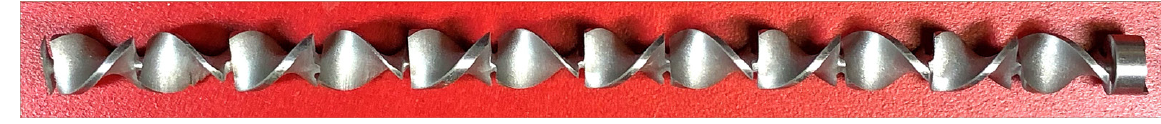
Figure 7: Twelve spiral segments machined on a 9.4 mm OD steel rod with the Rotary Axis.